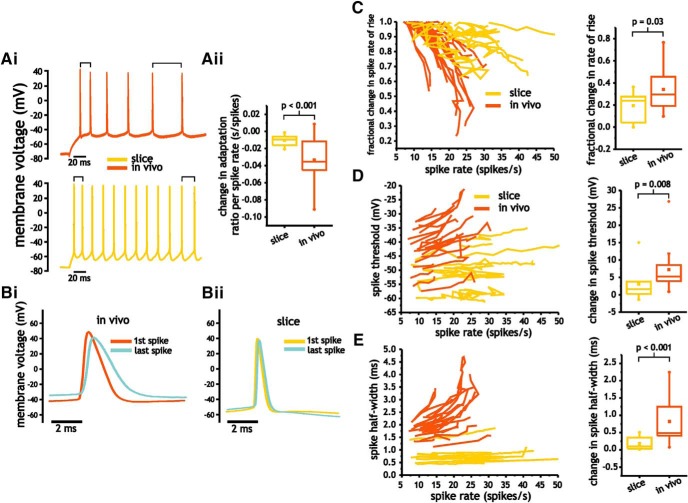
Pyramidal cells in vivo express greater changes in spike shape and spike frequency adaptation with increasing spike discharge frequency. A, Differences in spike frequency adaptation between in vivo and slice pyramidal cells. Representative voltage trace indicating greater adaptation in in vivo pyramidal cells (i) and plot of average change in adaptation ratio per spike rate (ii). B, Spike frequency-dependent changes in pyramidal cell spike shape in vivo (i) and in slices (ii). C–E, Plots of fractional change in spike rate of rise (C), voltage threshold (D), and half-width (E) as a function of spike discharge frequency along with the corresponding averages changes (between initial, low spike discharge rates, and highest discharge rates) for each of the spike measures.